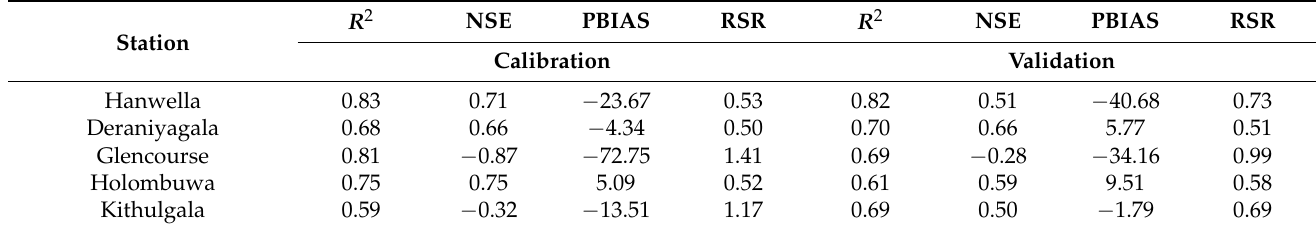
Table 8. Performance evaluations for the monthly discharge